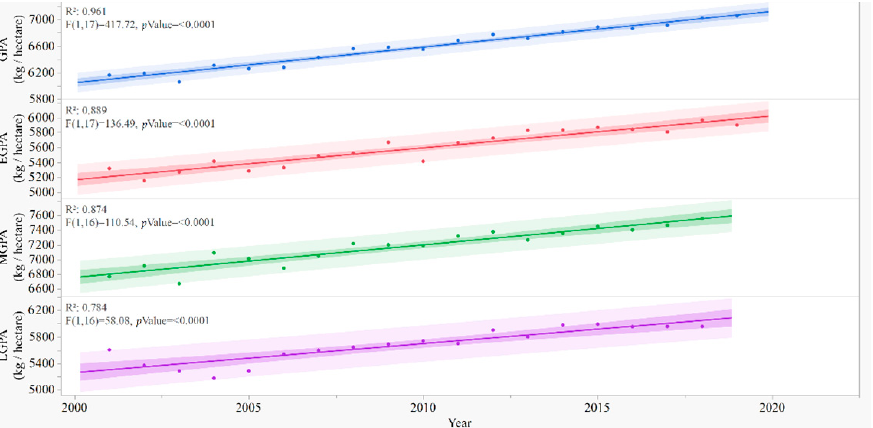
Figure 3. Grain yield per unit area (GPA) in total, early (EGPA), middle (MGPA), and late rice (LGPA) in the recent 20 years. Predictions, and R-squares, and results of F-test are from the polynomial regression model.